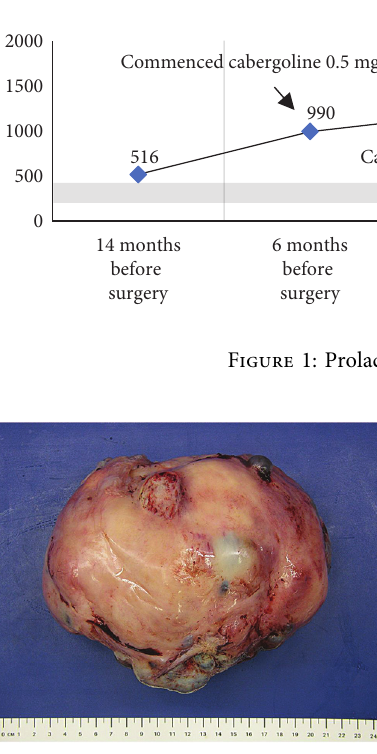
Figure 2: Macroscopic image of leiomyoma.